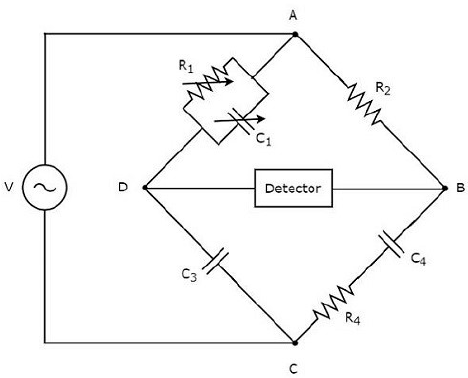
Figure 8. The capacitance bridge circuit is a useful AC bridge circuit that allows for the precise measurement of impedance values through balancing (unifying) the voltages at nodes B and D.